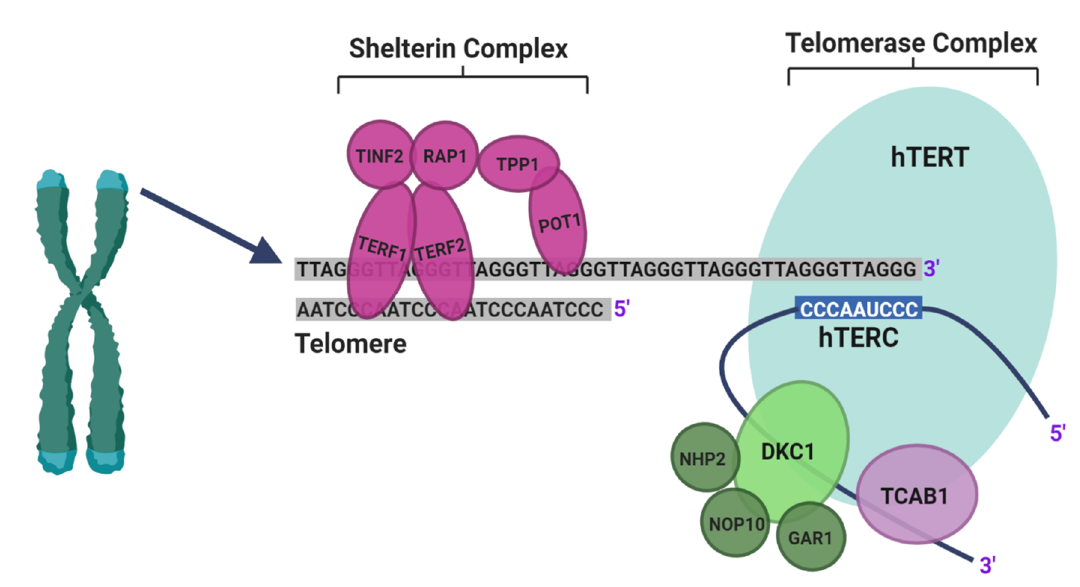
Figure 1. Schematic illustration of telomeres and the main components of telomerase, adapted from Hapangama et al. [12]. Telomerase is a holoenzyme comprising three core components: human telomerase reverse transcriptase (hTERT), human telomeric RNA component (hTERC) and dyskerin (DKC1). hTERT is a catalytic protein with transcriptase activity and hTERC provides the RNA template from which new telomeric DNA is synthesized [12]. NHP2, NOP10 and GAR1, in addition to DKC1, bind the H / ACA snoRNA motif at the 3 (cid:48) end of hTERC and stabilise newly transcribed telomeric RNA. The H / ACA region also binds telomerase Cajal body protein 1 (TCAB1). The shelterin complex is made up of telomeric repeat binding factors 1 and 2 (TERF1 and TERF2), repressor / activator protein 1 (RAP1), protection of telomeres 1 (POT1), TERF1 interacting nuclear factor 2 (TINF2) and TPP1 (encoded by the gene ACD ). POT1 binds directly to the single stranded 3 (cid:48) end of the telomere and forms a heterodimer with TPP1. TERF1 and TERF2 bind to the double-stranded telomeric sequence [11]. (Created with BioRender.com).